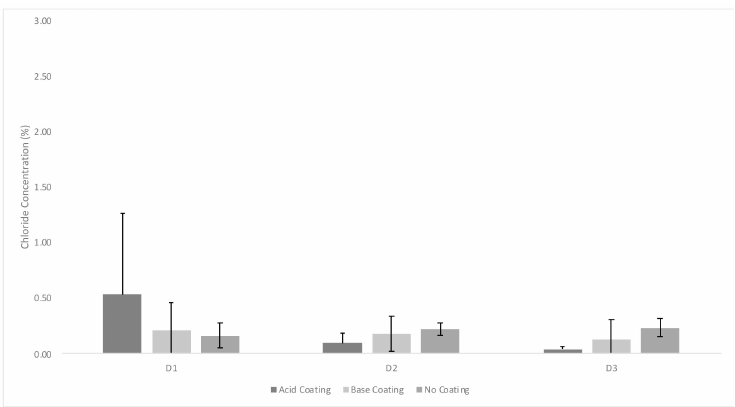
Figure 4. Cl − aerosol concentration percent on the denuder walls for the 3-ADS set-up. The values are given as the average percentage of the three trials conducted per coating type (acid, base, or no coating) for a total of nine trials.